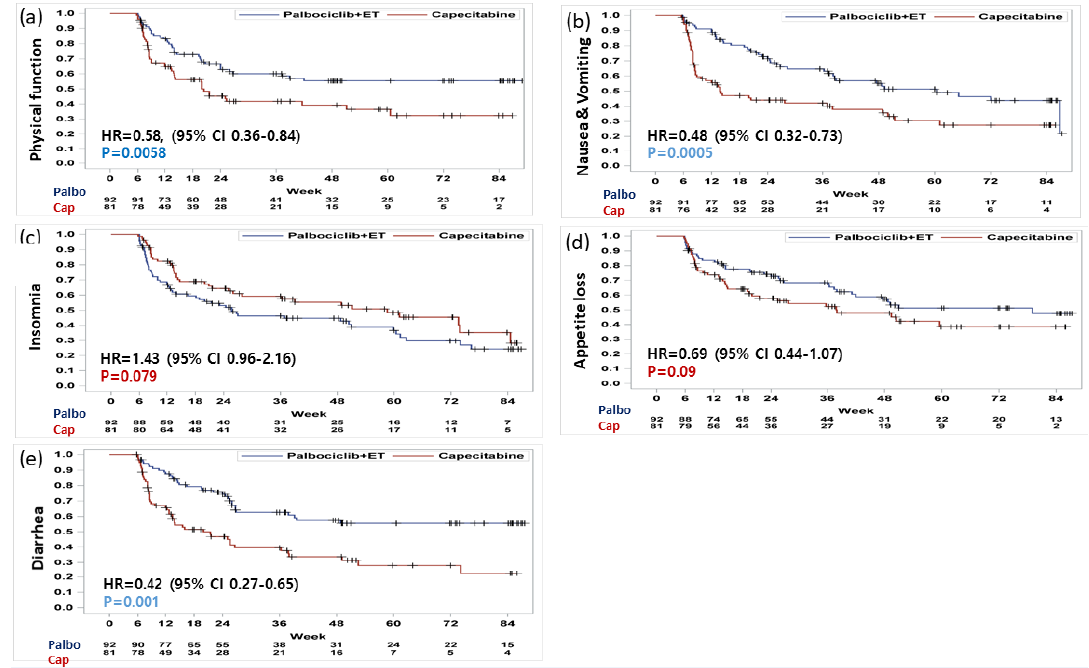
Figure 4. Time to definitive clinically meaningful deterioration in EORTC QLQ C-30. Deterioration in ( a ) physical function, ( b ) nausea and vomiting, ( c ) insomnia, ( d ) appetite loss, and ( e ) diarrhea. Cancers 2020 , 12 , x